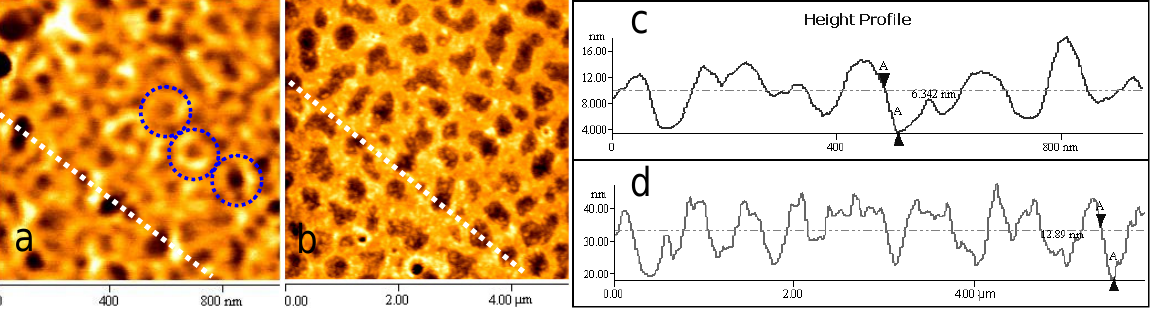
Figure 3. AFM images of chitosan film with mesh structure (a, 1.0 mg/ml; b 2.5 mg/ml). Figure c and d are height profile generated along the white broken lines in Figure a and b, respectively. The average rough (Ra) is 1.74 nm (a) and 5.53 nm (b), and the mean thickness of film is 6.45 nm (a) and 11.65 nm (b) according to statistic